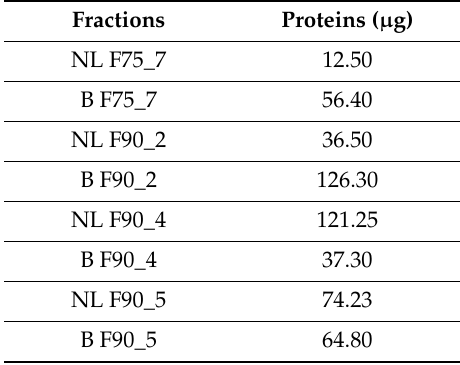
Table 2. Bradford analysis of the fractions (bound, B and non-bound, NL) F75_7, F90_2, F90_4,